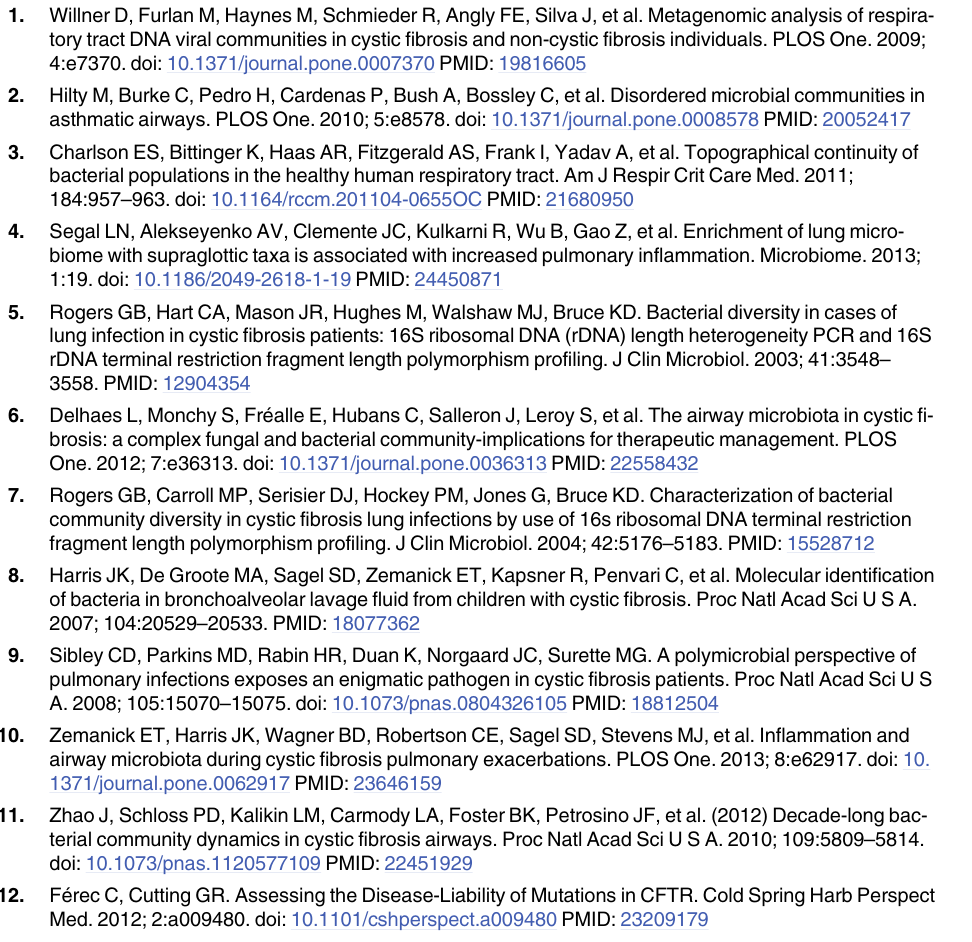
S3 Table. Correlation (Spearman test) between relative abundance of OTUs belonging to the major core microbiota and qPCR results. S4 Table. Uncorrected p-values associated with Spearman correlations between relative abundance of OTUs belonging to the major core microbiota and qPCR